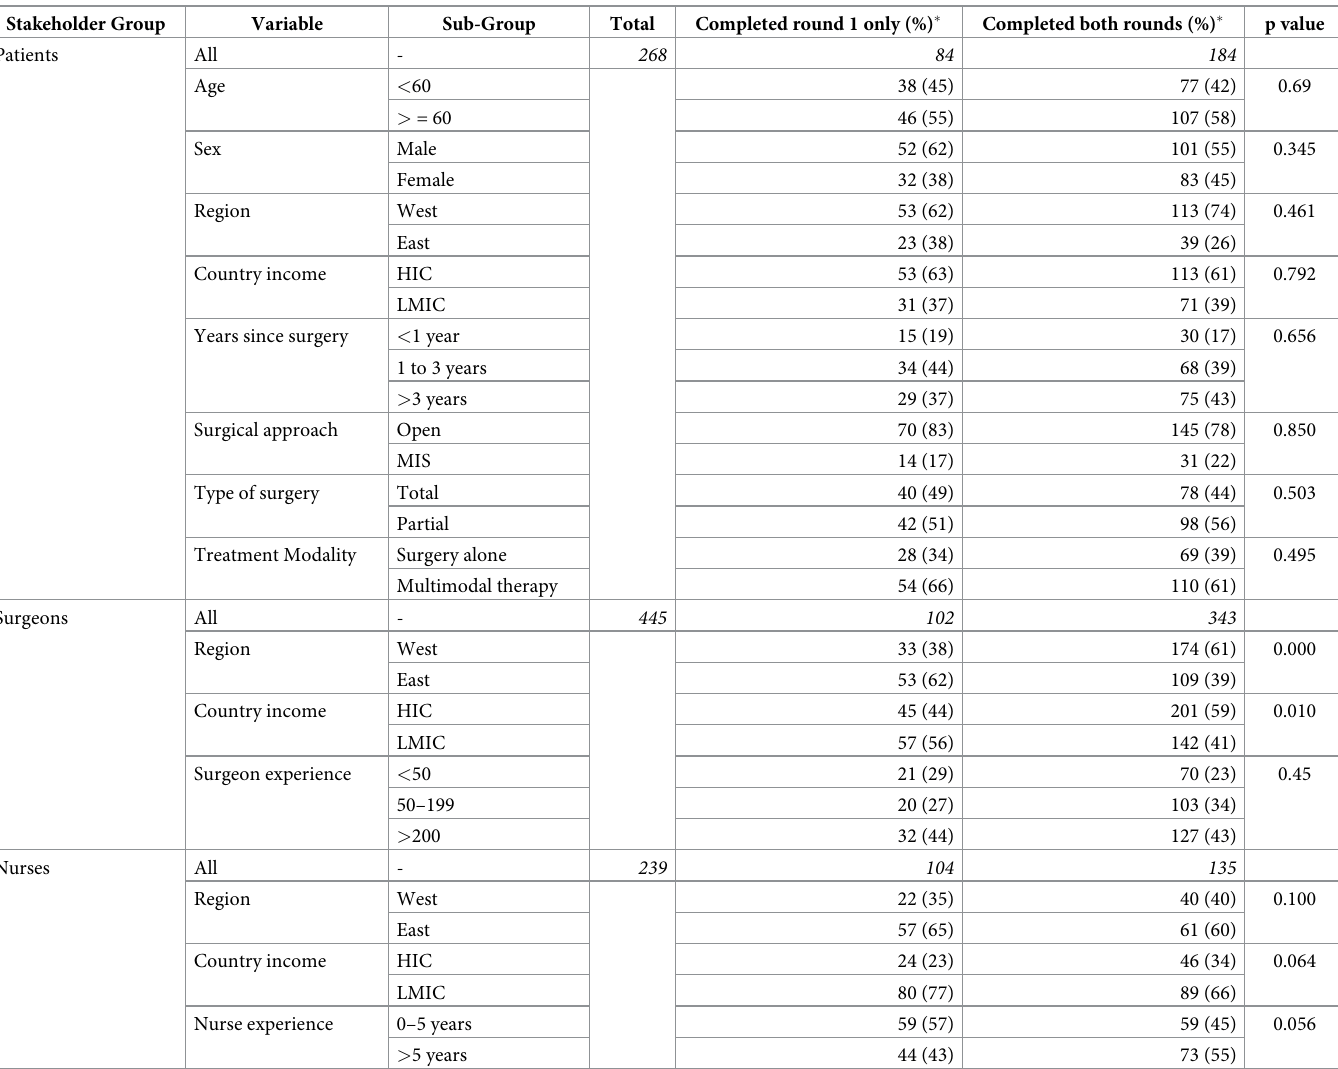
Table 1. Demographic characteristics of participants included in analysis of round 1 and 2